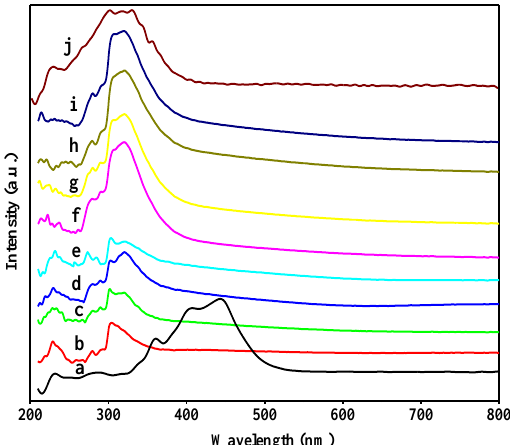
Figure 5. UV-Vis diffuse reflectance spectra of various samples. (a) Bulk Tungsten oxide (WO 3 ); (b) 20 wt %;(c) 30 wt %; (d) 35 wt %; (e) 40 wt % WO 3 /UiO-66; (f) 5 wt % B 2 O 3 -40 wt % WO 3 ; (g) 10 wt % B 2 O 3 -40 wt % WO 3 ; (h) 15 wt % B 2 O 3 -40 wt % WO 3 ; (i) 20 wt % B 2 O 3 -40 wt % WO 3 /UiO-66; and, (j) 11.4 wt % W-HMS.